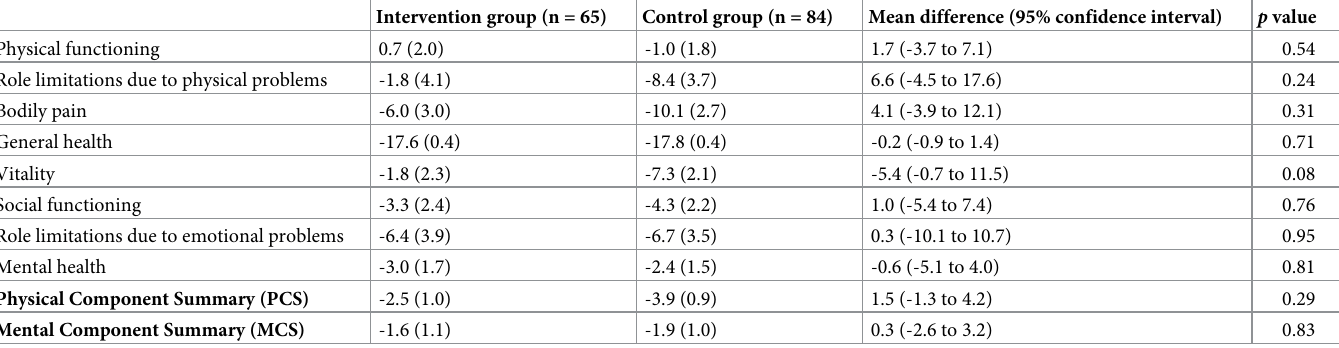
Table 5. Quality of life measured by the SF-36, change from baseline scores five years after lifestyle intervention according to allocation